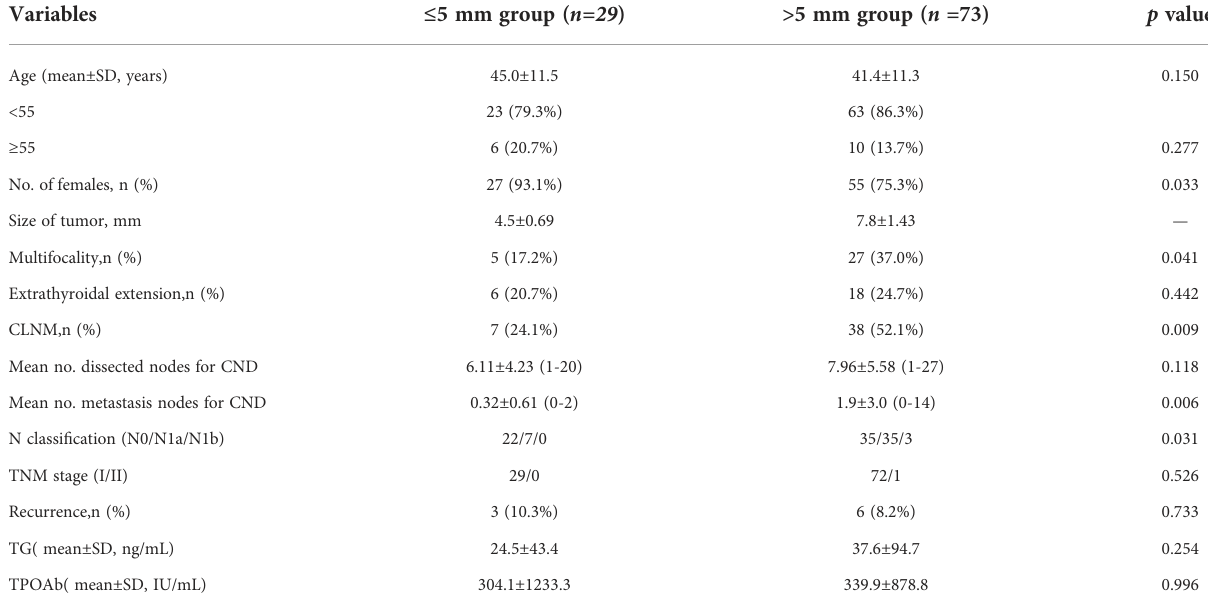
TABLE 1 Clinical characteristics of patients with papillary thyroid microcarcinoma located in the isthmus by size.